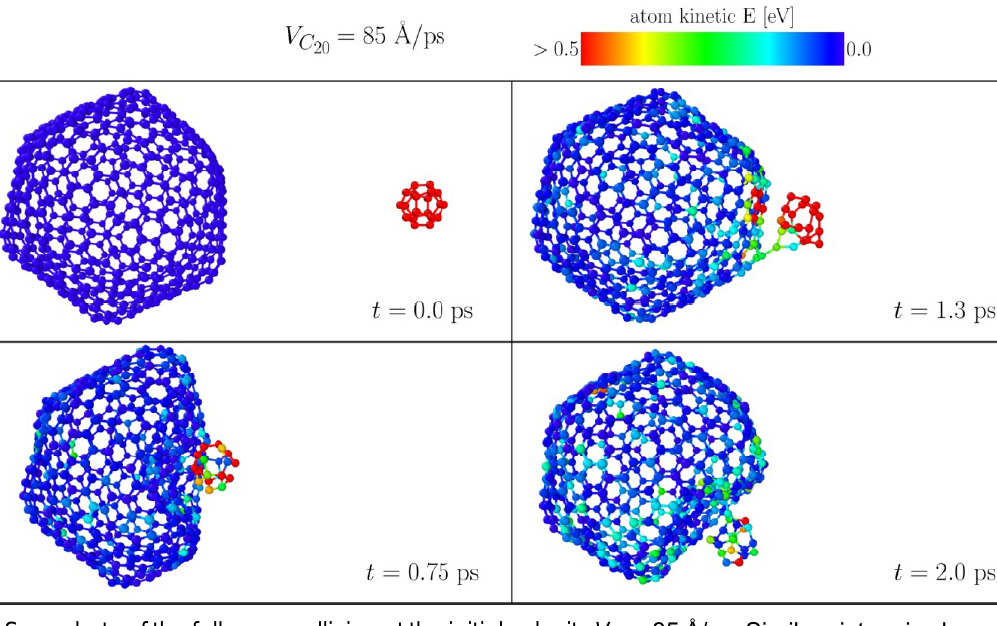
Fig. 5. Snapshots of the fullerene collision at the initial velocity V collision velocities in the range 83< V